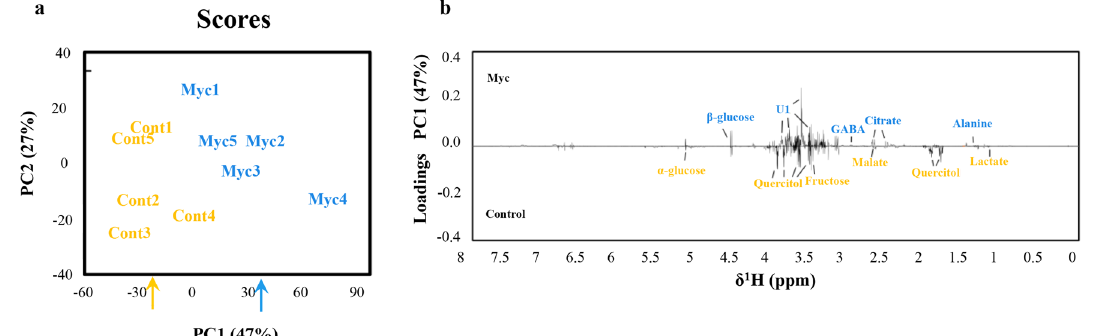
Figure 2. Overview of the metabolic reprograming (analysed by 1H NMR) in mycorrhizal (Myc) and non- inoculated (Cont.) roots interpreted using PCA. ( a ) Biplot of the second principal component (PC2) versus the first principal component (PC1) scores. ( b ) Loading values of the first principal component (PC1). The molecular name of the elucidated peaks with significantly different concentration in mycorrhizal compared to non-inoculated roots is highlighted; blue corresponds to metabolites with higher concentrations in mycorrhizal roots and orange corresponds to those with higher concentration in non-inoculated scores to establish the importance of mass features. The scores plot showed a clear separation between mycor- rhizal and non-inoculated groups (Fig. 4b), suggesting a separated root metabolite profile corresponding to each treatment. Internal cross-validation showed a value of Q 2 above 0.8, indicative of a good predictive performance of the PLS-DA model, with a maximum Q 2 achieved with 3 PLS components (Fig. 4c). Masses with the highest discriminative capacity (VIP score > 1) were selected as the most important metabolites that contributed for the separation of the metabolic changes identified. The VIP score describes a quantitative estimation of the dis- criminatory power of each individual feature 15 and VIP > 1 is commonly used as a cut-off for selecting the most